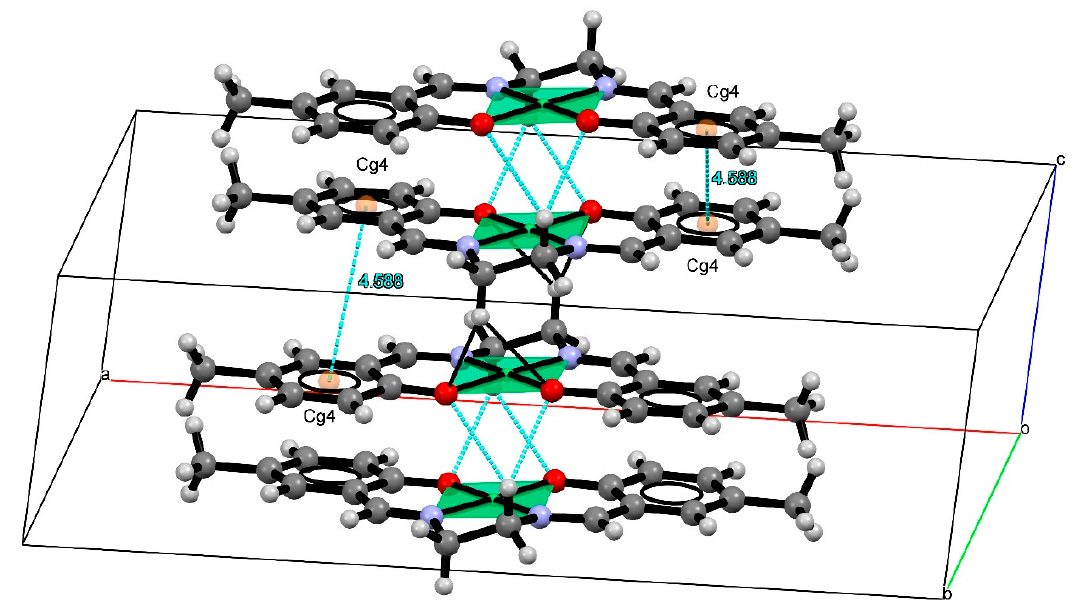
Figure 2. Crystal array of compound NiMe salen shows the view along the b- axis and with perspective to plane formed by a-c axes emphasizing the π -stacking and R 1 2 (4) motif .